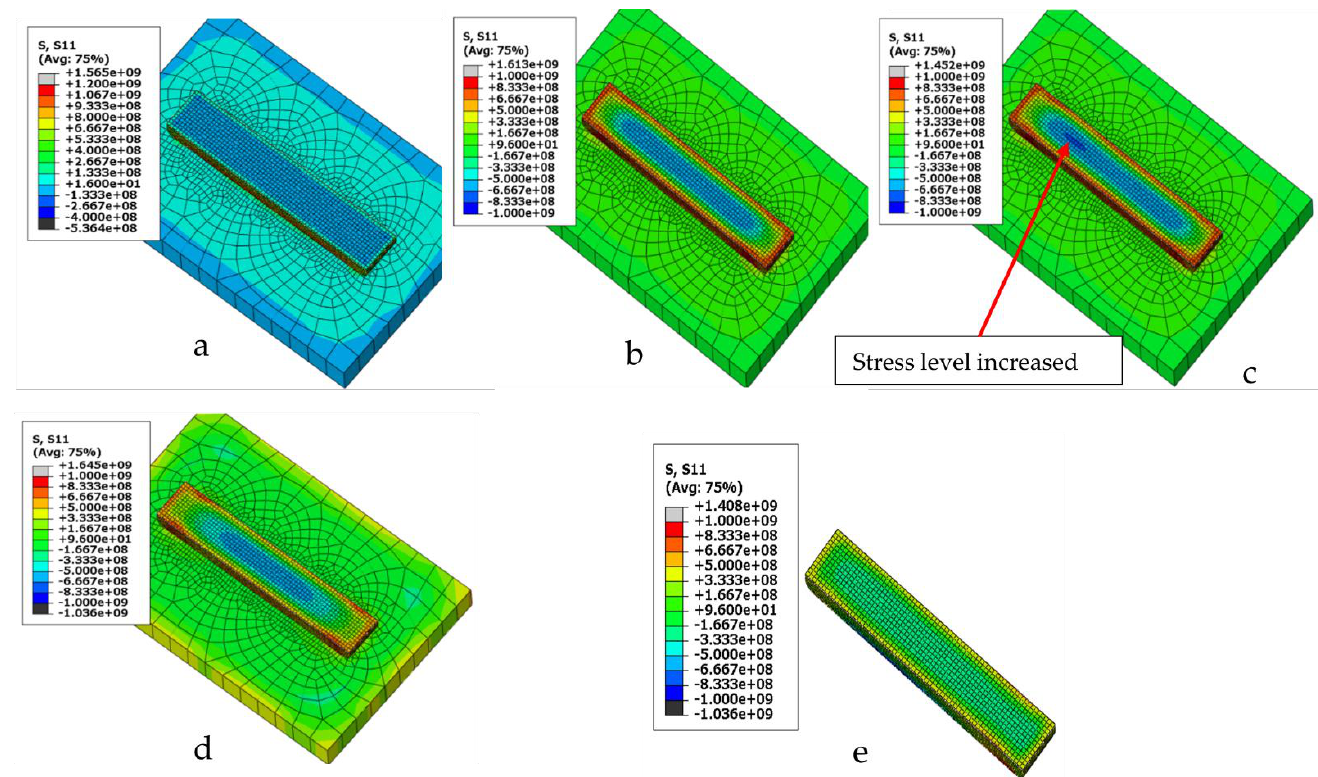
Figure 10. Stress evolution [Pa] in building direction at a cross-section 4 mm away from base plate (sections above the current layers are removed for visualization): ( a ) when the new combined layer is cooled, ( b ) when the geometry change happens at height of 20 mm, ( c ) when the build height reaches 40 mm, ( d ) when the entire part is cooled down to room temperature, ( e ) when the base plate is removed.